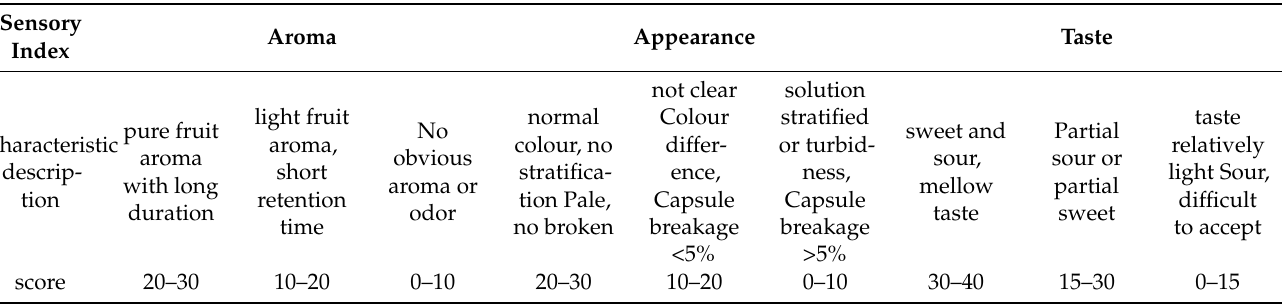
Table 1. Standard of sensory